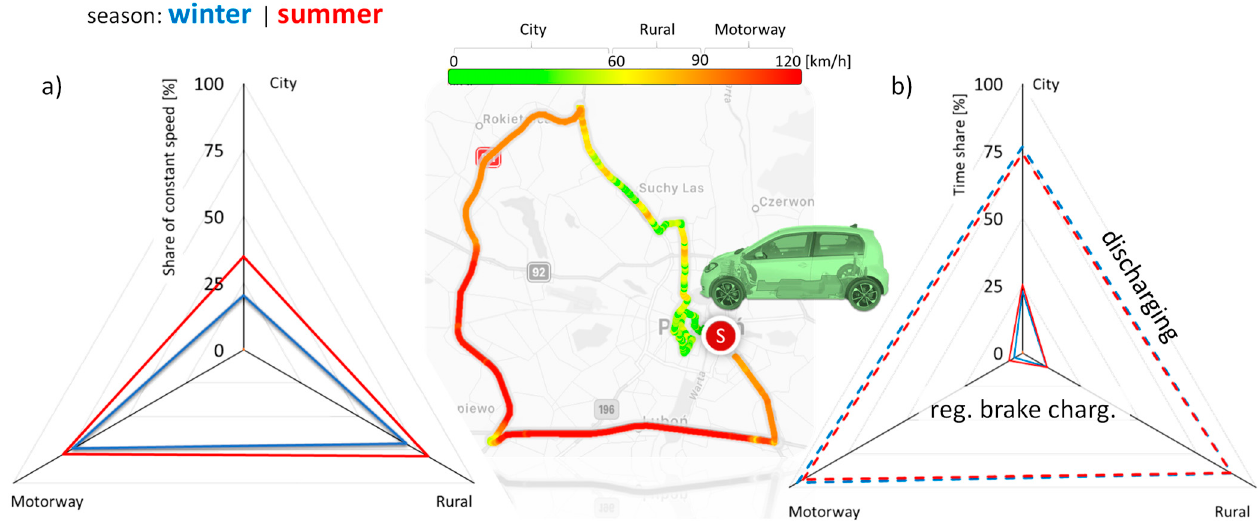
Figure 20. Time share of: ( a ) constant speed of vehicle during the test, ( b ) battery charging and discharging during the test; with division into particular test sections which refer to the type of the route: urban, rural and motorway.